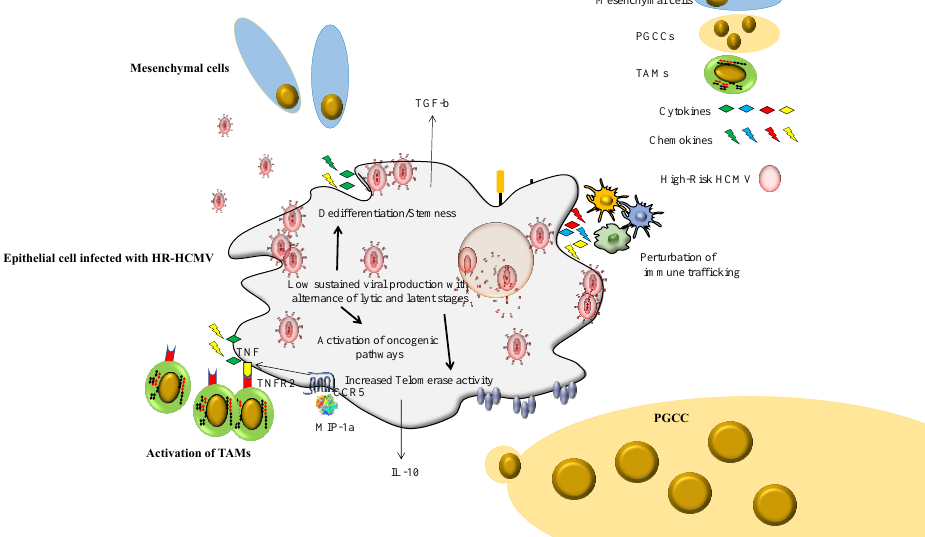
Figure 2. Impact of the HR-HCMV strains in the infected cell landscape and tumor microenvironment. HCMV infection fulfills all of the hallmarks of cancer, including sustained prolif- erative signaling, deregulating cellular energetics, resisting cell death, favoring